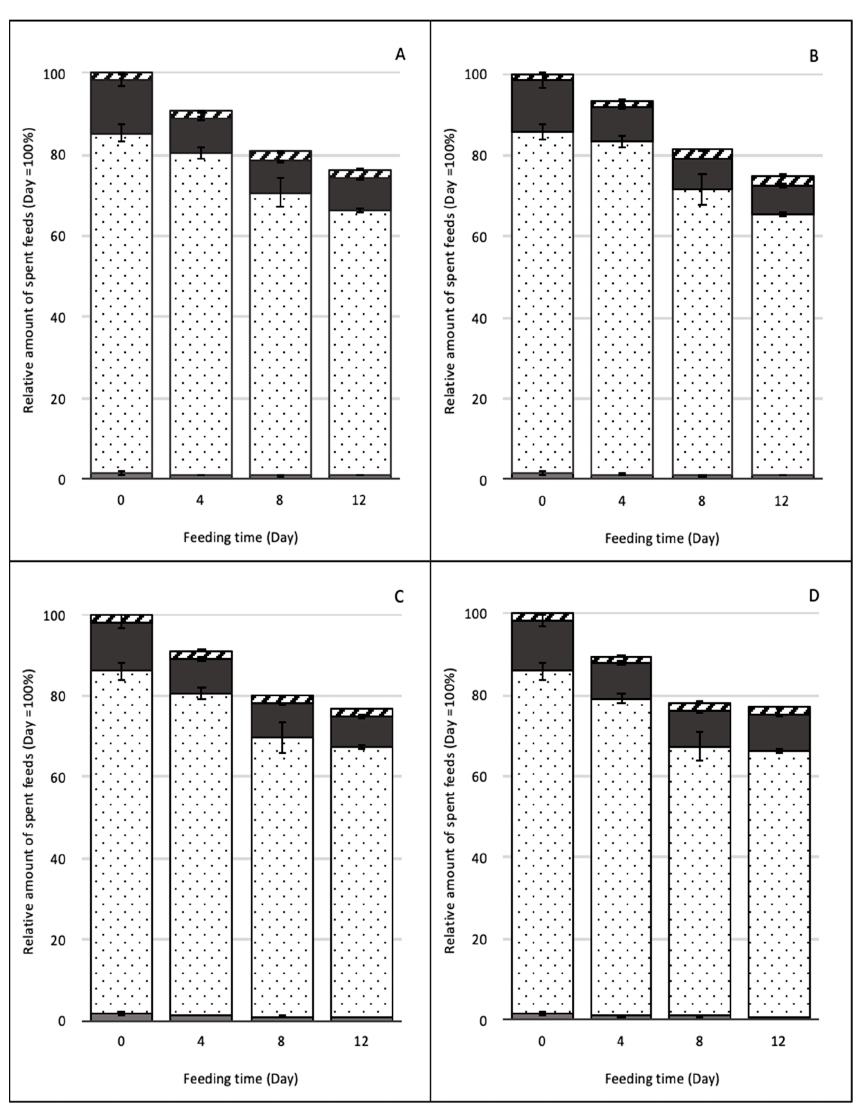
Figure 1. The relative amount of spent feed during black soldier fly larvae (BSFL) digestion. Bars indicate differences in nutrient composition of spent feed after BSFL digestion based on initial day. During feeding time, the residual amount was calculated by taking into account the weight of Fusarium-damaged kernels (FDKs) consumed by BSFL. Each bar was divided according to the ratio of nutrients: hatched area, ashes; black area, proteins; dotted area, carbohydrates; gray area, lipids. Each panel represents the results from ( A ) control without any inoculum (i.e., unfermented FDK), ( B ) fermented FDK with Lactobacillus plantarum , ( C ) fermented FDK with Aspergillus oryzae , and ( D ) fermented FDK with both L. plantarum and A. oryzae